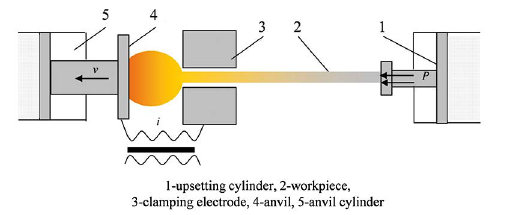
Figure 4: Defects in electric upsetting: (a)external waviness, (b) secondary upsetting